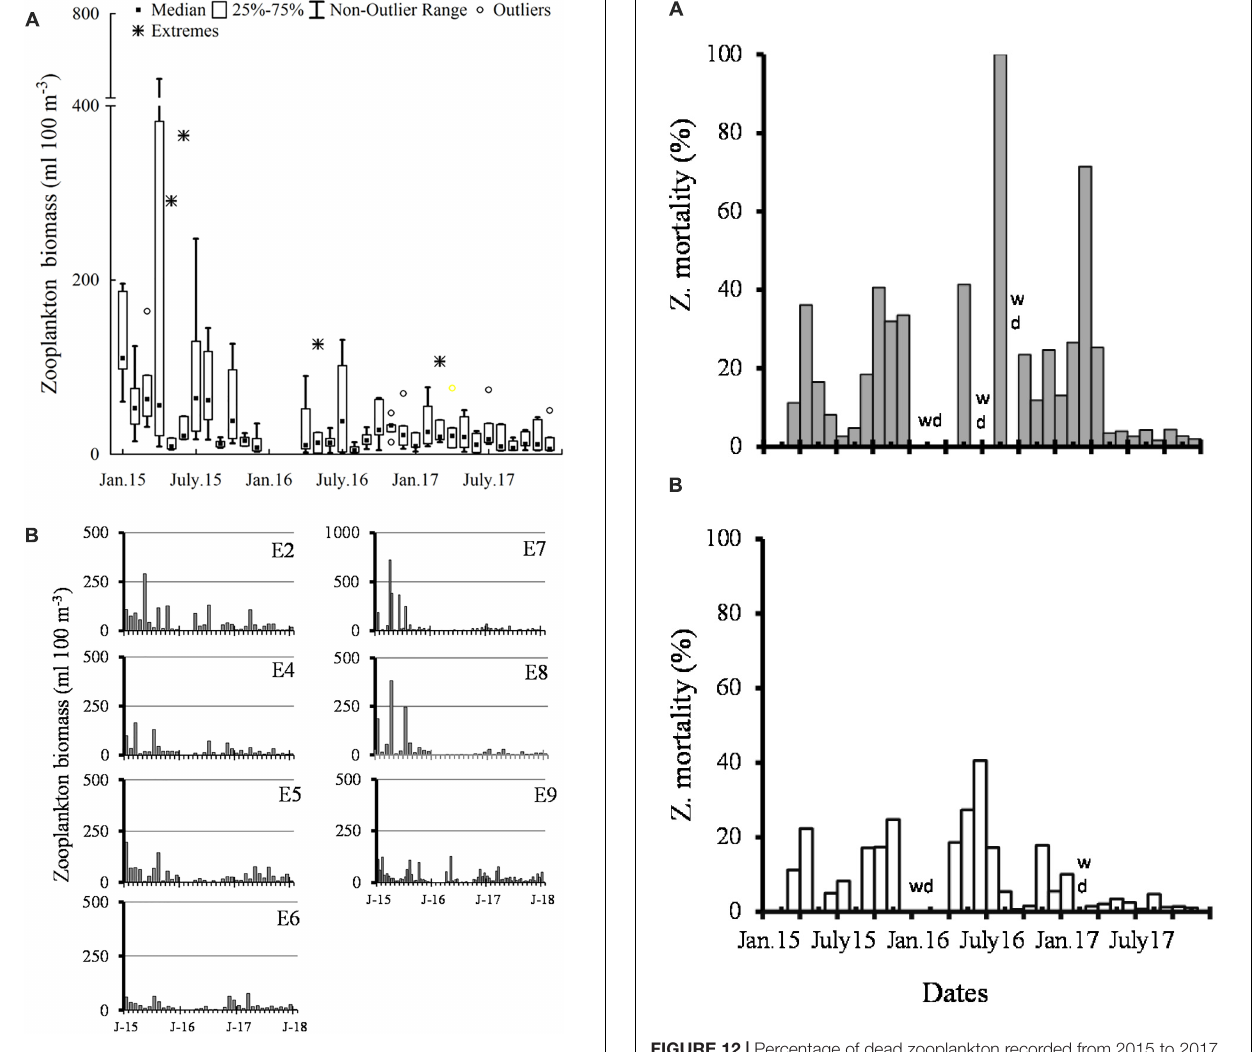
FIGURE 11 | Zooplankton biomass (mL 100 m − 3 ) recorded from 2015 to 2017. (A) Time-series of all data; (B) ZB measured in the E2–E9 sampling stations. J, January.